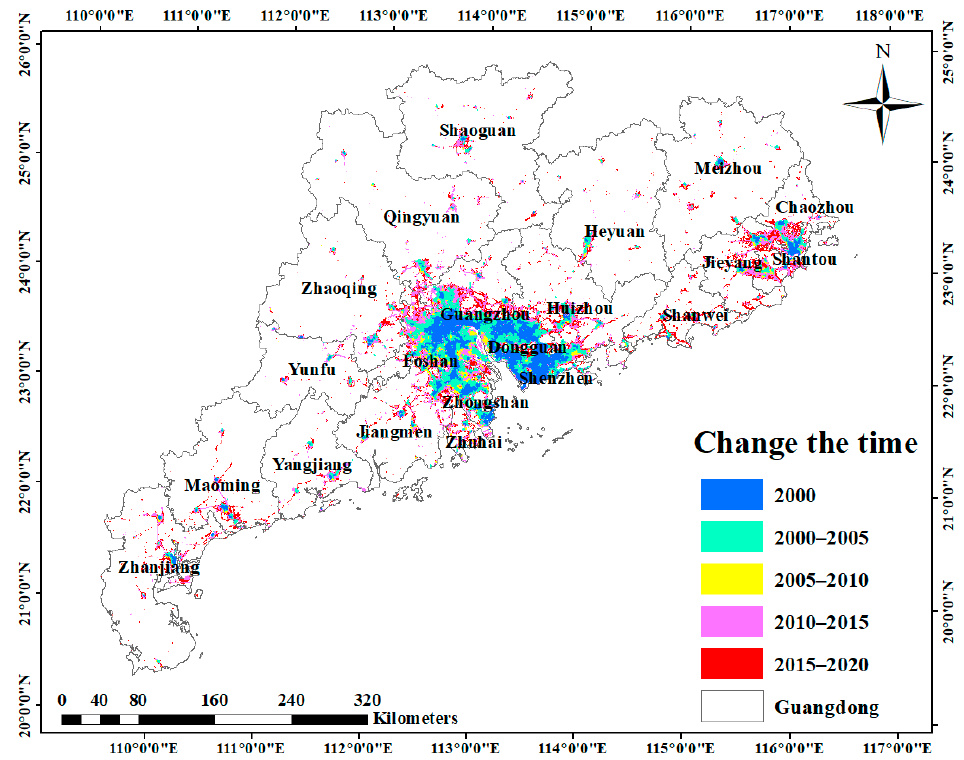
Figure 8. Extraction area of built-up areas in Guangdong Province. Table 2. Statistics of urban agglomeration in Guangdong